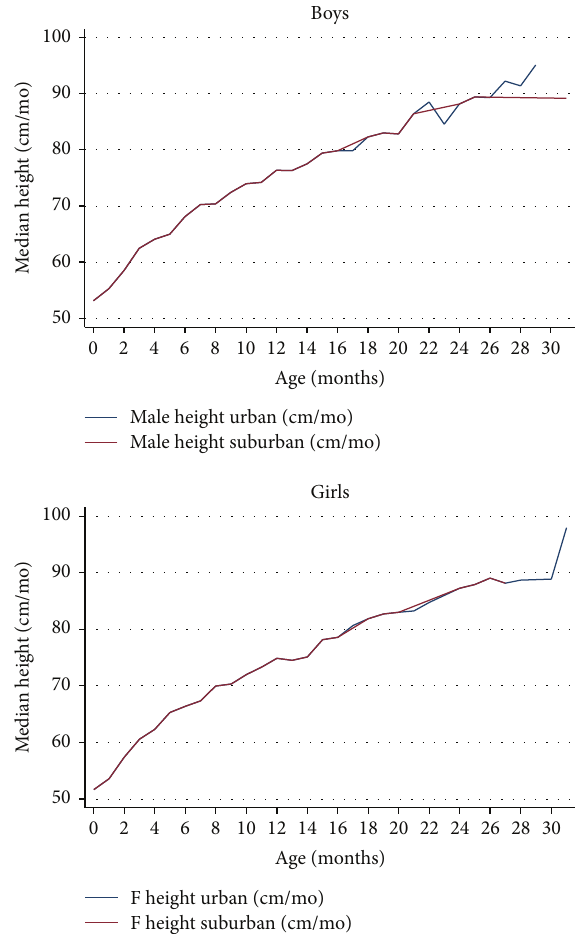
Figure1:Growthtrajectory(height)bygeographiclocationforboys and girls.